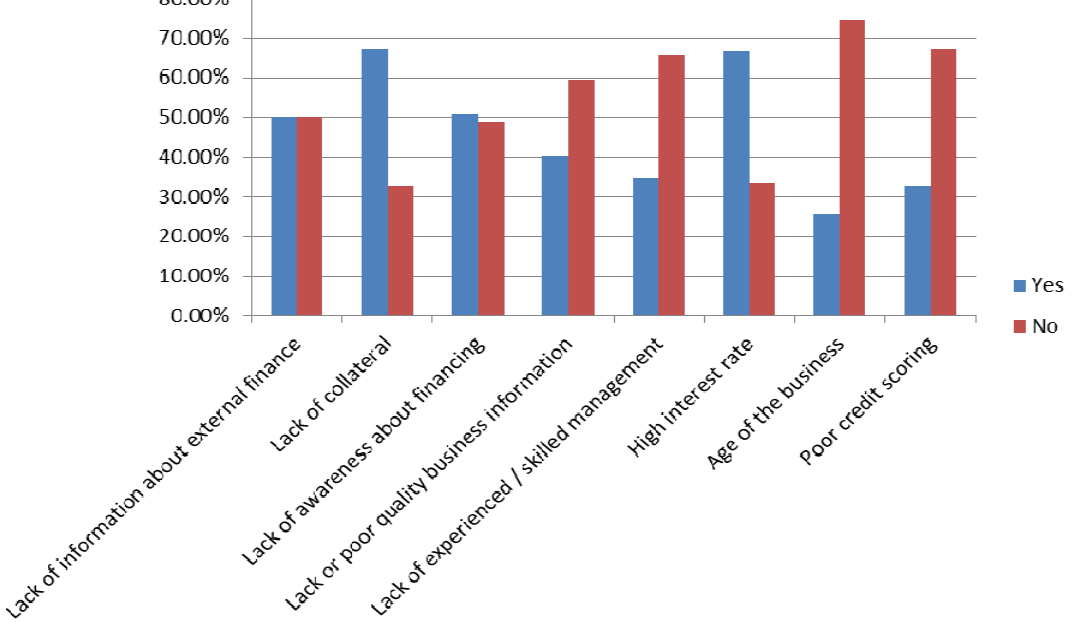
Fig. 1. Reasons for difficulties with access to finance by SMEs in KZN,